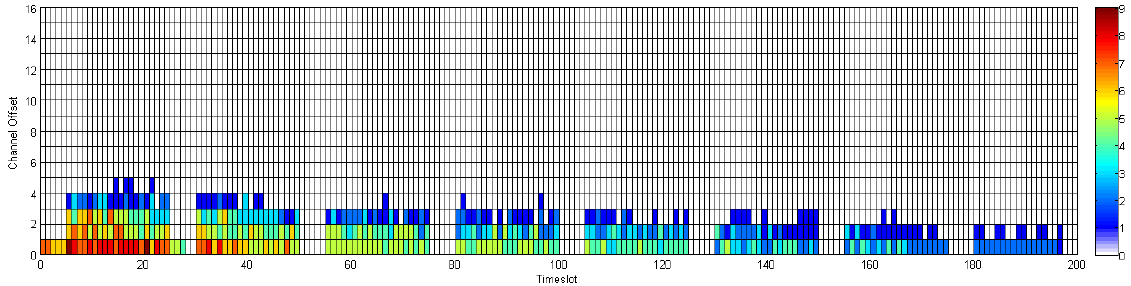
Figure A1. Communication schedule of D-MSR network with seven nodes per one-hop neighborhood.